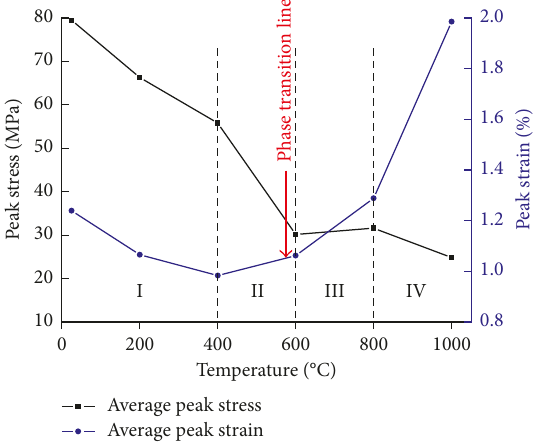
Figure 4: Average peak stress and peak strain with